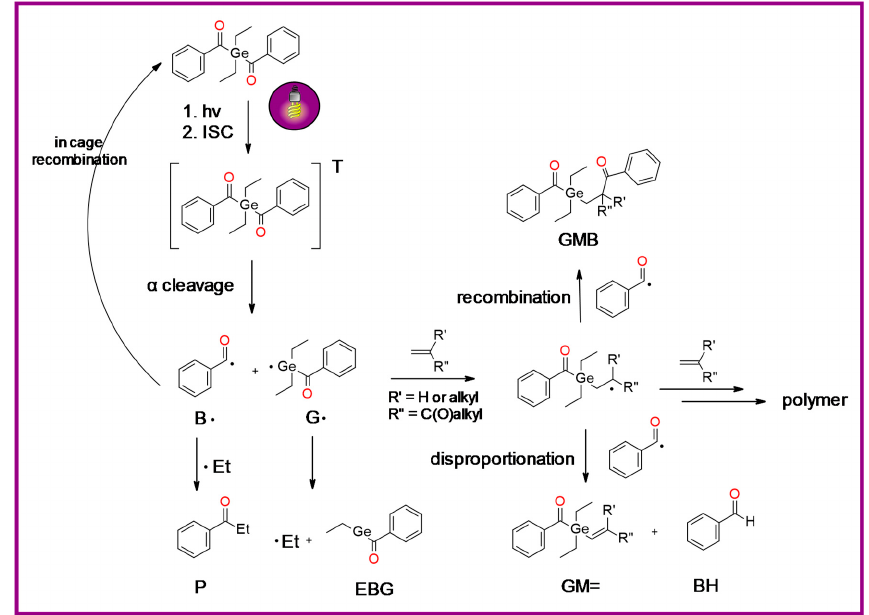
Figure 12. Synthetic pathway to obtain Ivocerin ® product.